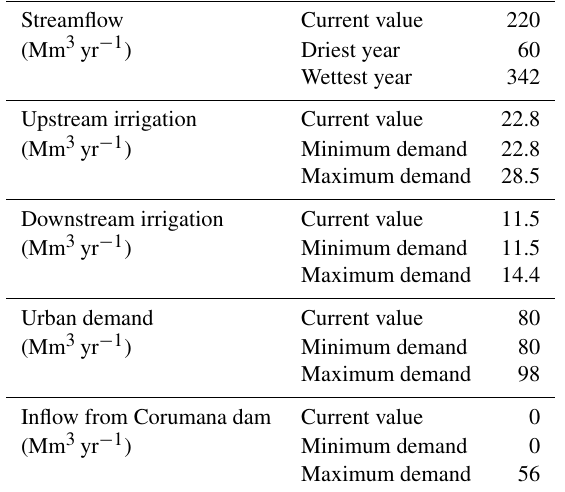
Table 3. Statistical extremes of the SOWs aggregated by uncertainty